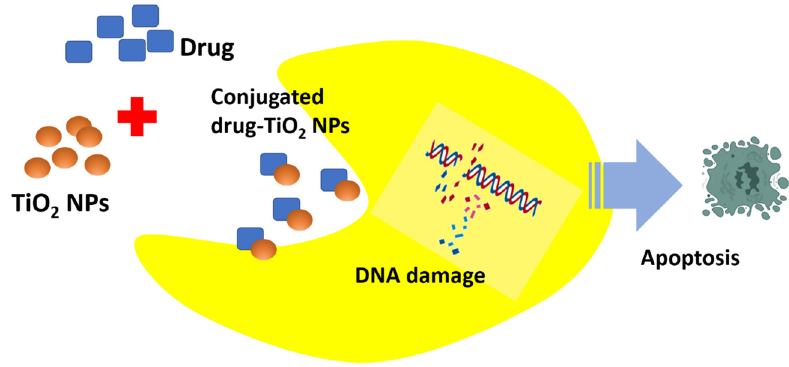
Figure 9: Schematic sketch of the drug delivery system, using TiO 2 - NPs. NPs are conjugated with the desired drug, and they are taken by the cell, cause DNA damage, and induce an apoptotic